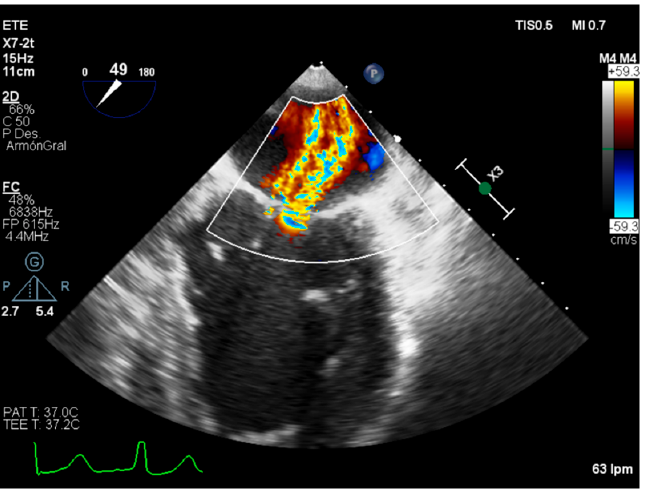
Figure 3. Transesophageal echocardiography. Mitral valve from Figure 4 with mild mitral regurgi- tation after transcatheter edge-to-edge repair procedure.